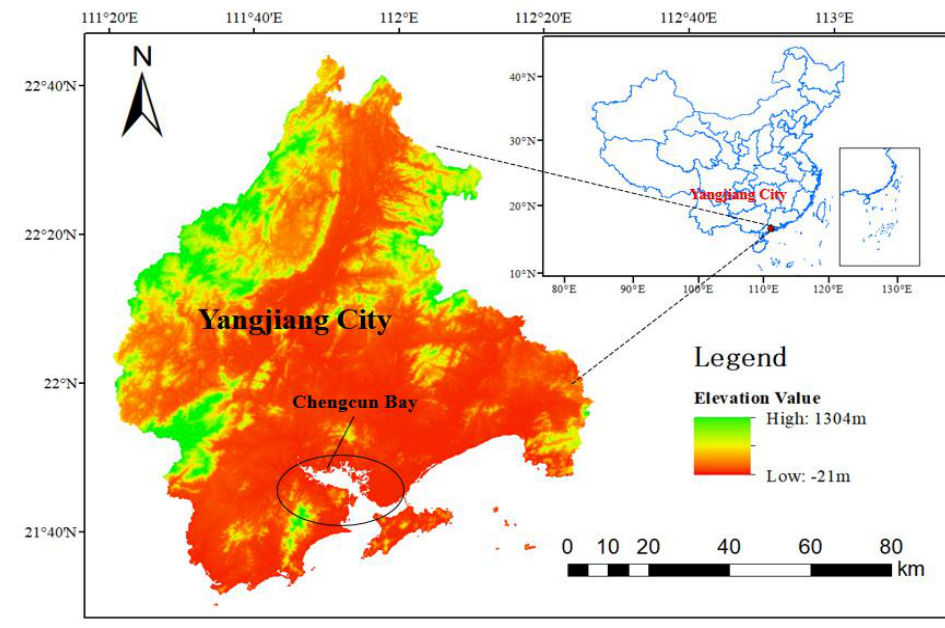
Figure 1 . Geographic location of the study area. Figure 1. Geographic location of the study area.